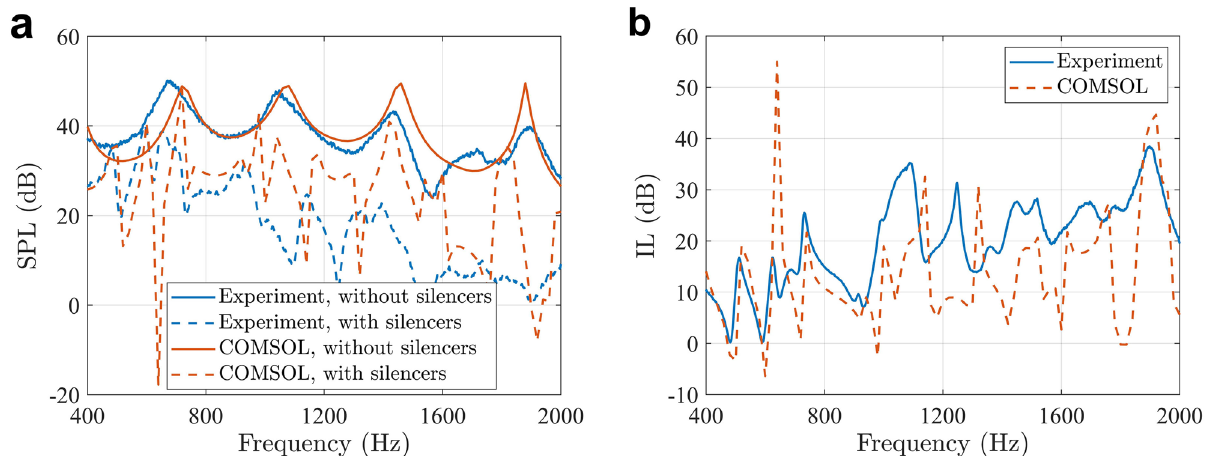
Figure 6. (a) The measured SPLs at the evaluation point and the comparisons with the numerical simulation results obtained from COMSOL. (b) The insertion loss of the silencers in the experiments and numerical simulations.